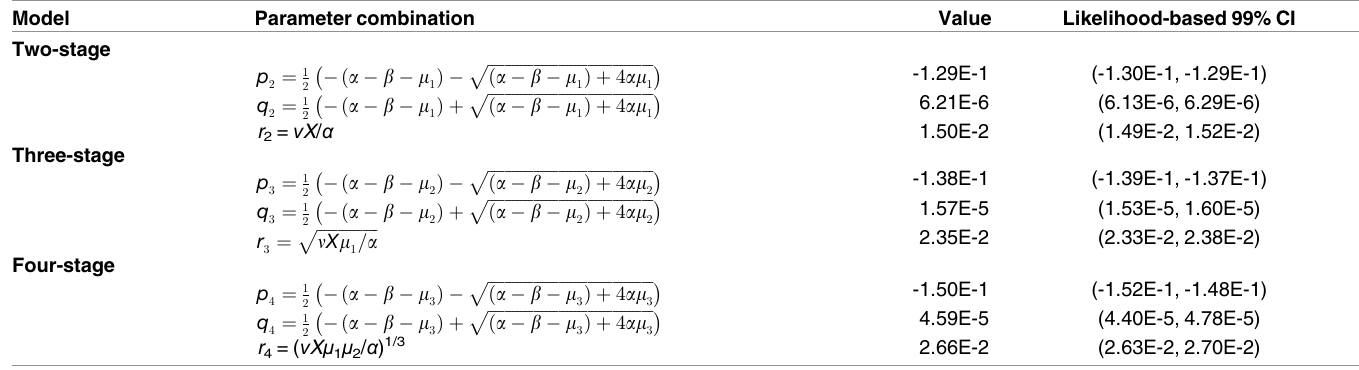
Fig 4. Two-stage model profile likelihoods. Profiles of the relative negativelog-likelihood (NLL) of the two- stage clonal expansionmodel as each of the parameter combinations p 2 , q 2 , and ν X / α are varied while the remaining parameters are fit. The gray dotted line gives the α = 0.01 thresholdfor simultaneous confidence intervals based on the relative negativelog-likelihood. All three parameters are identifiable. https://doi.org/10.1371/journal.pcbi.1005431.g004 Table 1. Best-fit parameters and likelihood-based 99% confidence intervals. Best-fit parameters and likelihood-based 99% confidenceintervals for the fits of the two-, three-, and four-stage clonalexpansionmodels (with parameterizations using only practically identifiableparameter combinations and given in Eqs (2), (9) and (11) respectively) to age-specific incidenceof pancreatic